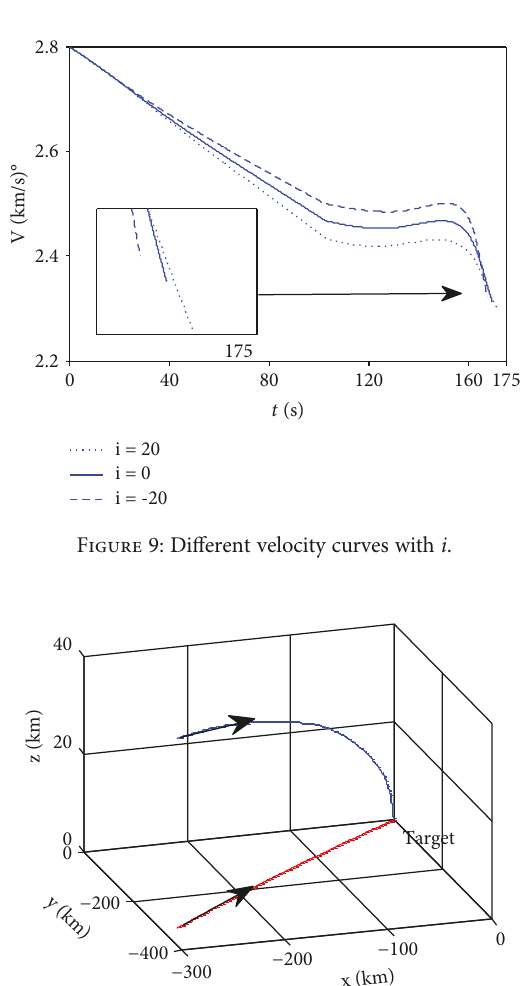
Figure 10: Three-dimensional trajectories.